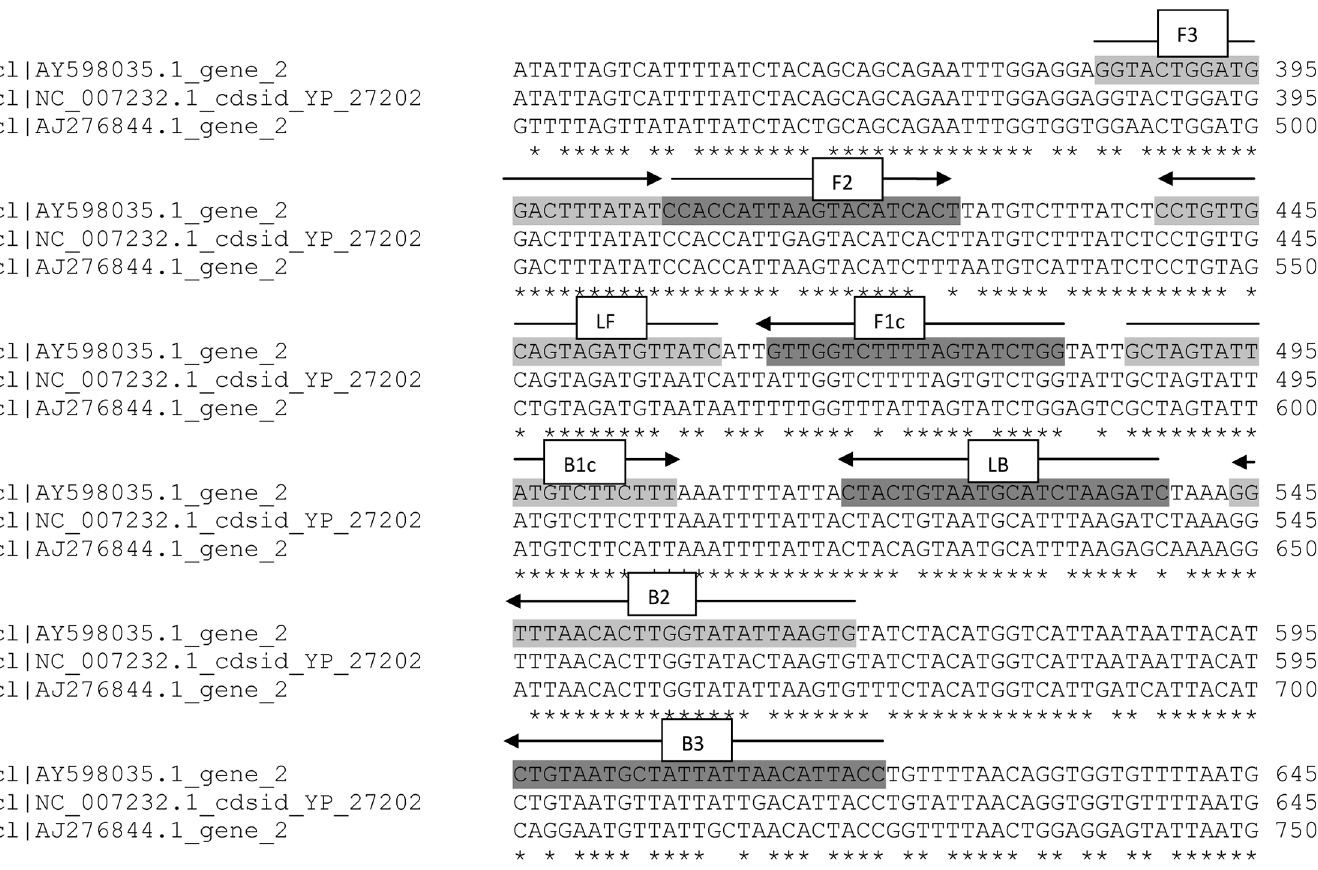
Fig 2. P . vivax VIV2 HtLAMP primer set superimposed on alignments of P . vivax (AY598035), P . falciparum (AJ276844) and P . knowlesi (NC_007232) cox1